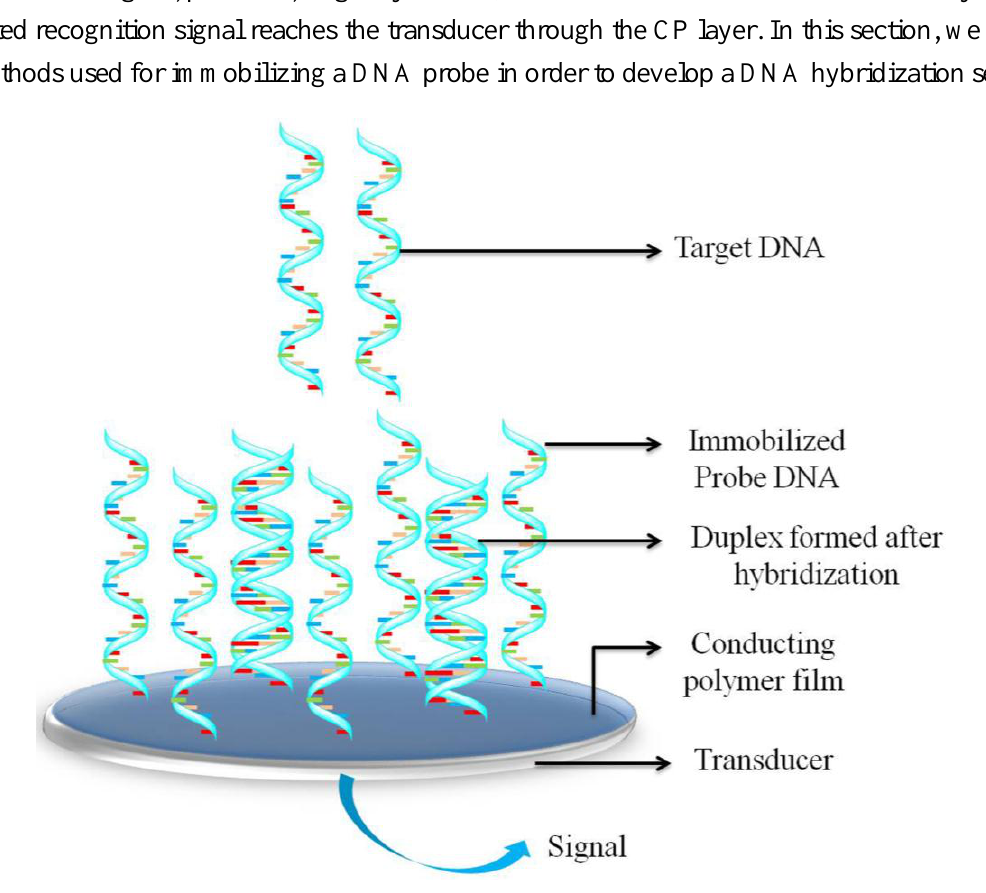
Figure 1. Schematic representation of a general electrochemical DNA sensor based on conducting